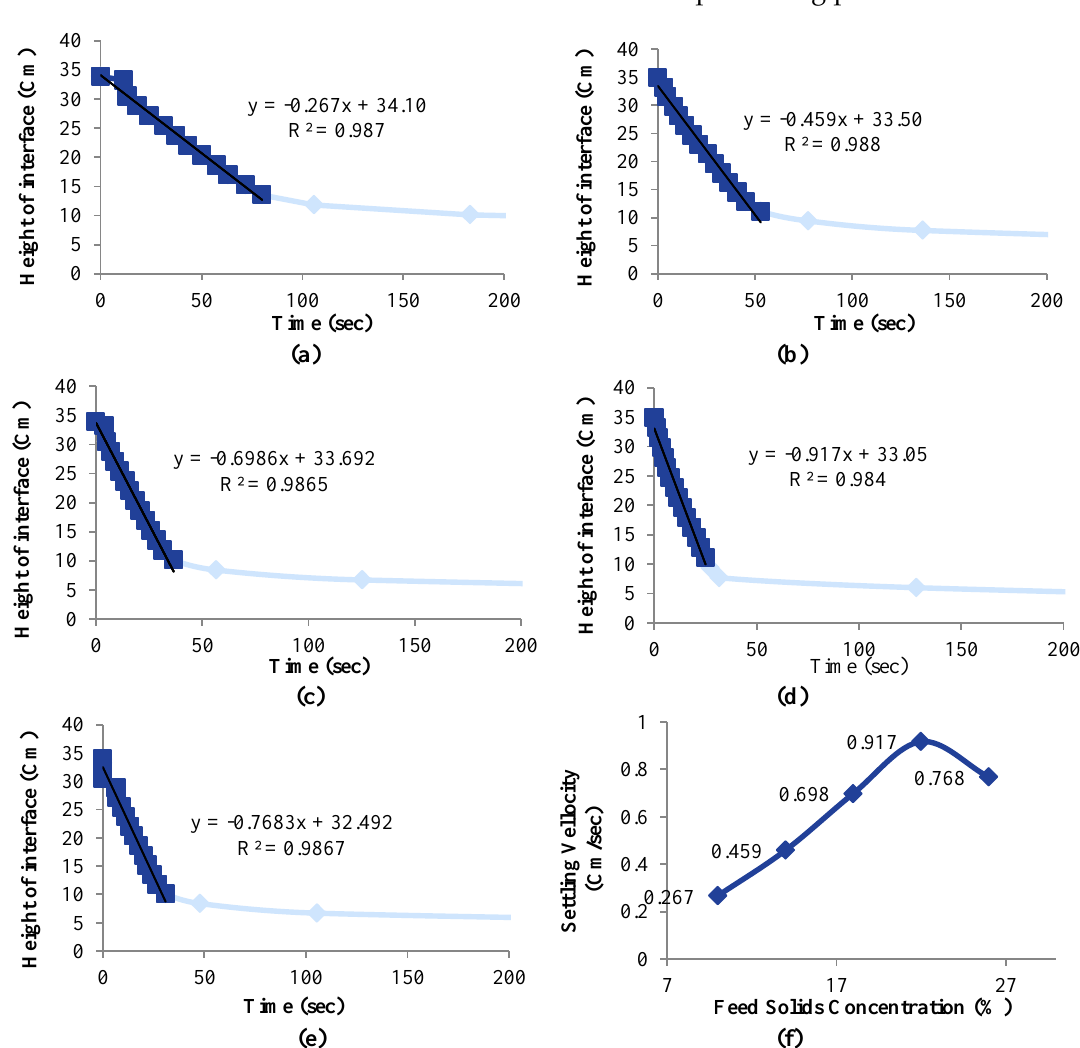
Figure 4. The variation of the height of goal and the settling rate of pulp solids in content Flocculant (a to f) (a). The variation of the height of the goal and settling rate of 8% pulp solids in content of 10 ppm flocculant; (b). The variation of the height of the goal and settling rate of 8% pulp solids in content of 14 ppm flocculant; (c). The variation of the height of the goal and the settling rate of 8% pulp solids in content of 18 ppm flocculant; (d). The variation of the height of the goal and settling rate of 8% pulp solids in content of 22 ppm flocculant; (e). The variation of the height of the goal and the settling rate of 8% pulp solids in content of 26 ppm flocculant; (f). Influence of the flocculant A26 (22 grams per ton) of pulp solids settling rate of